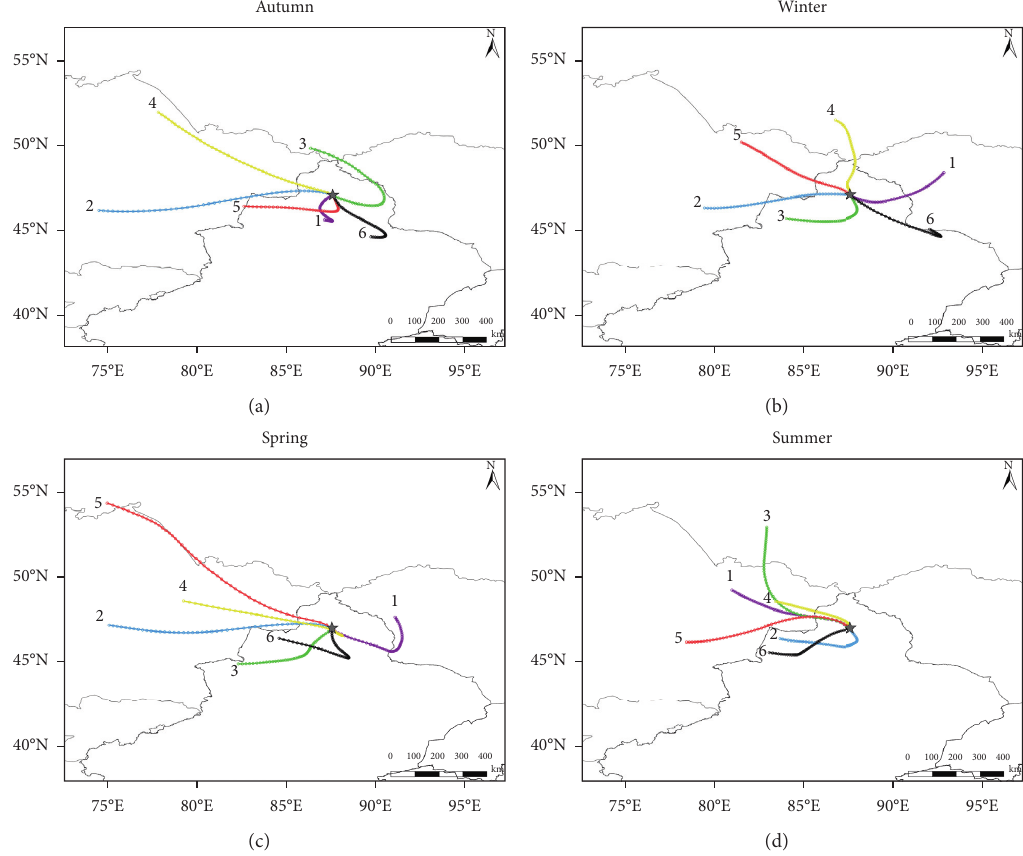
Figure 6: Seasonal distribution of the back trajectories clusters in Akedala from September 2017 to August